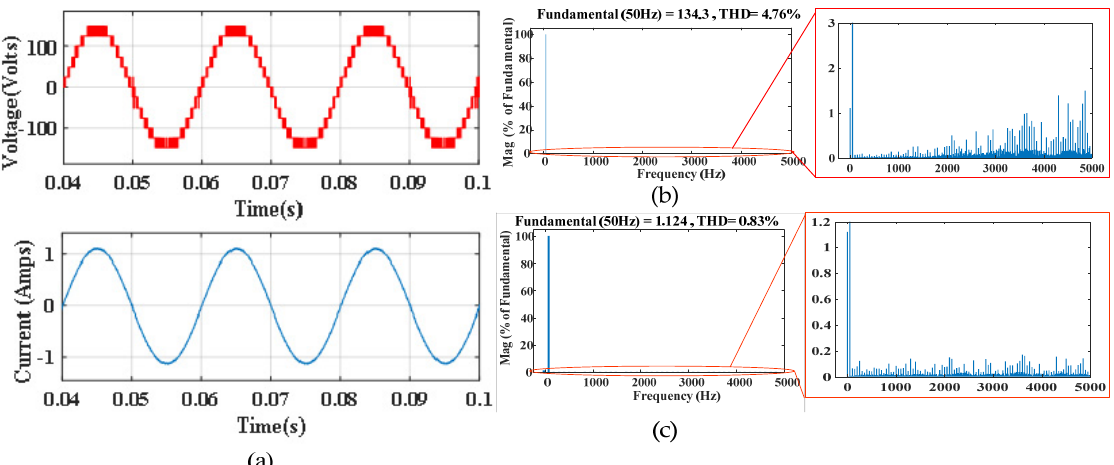
Table 2. Simulation parameters.